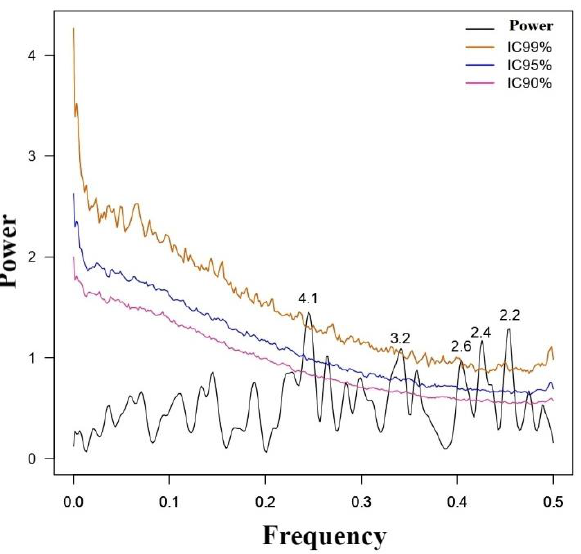
Figure 9. Power spectral analysis for the six-month reconstructed SPEI (February–May). Values above the confidence limits are significant.